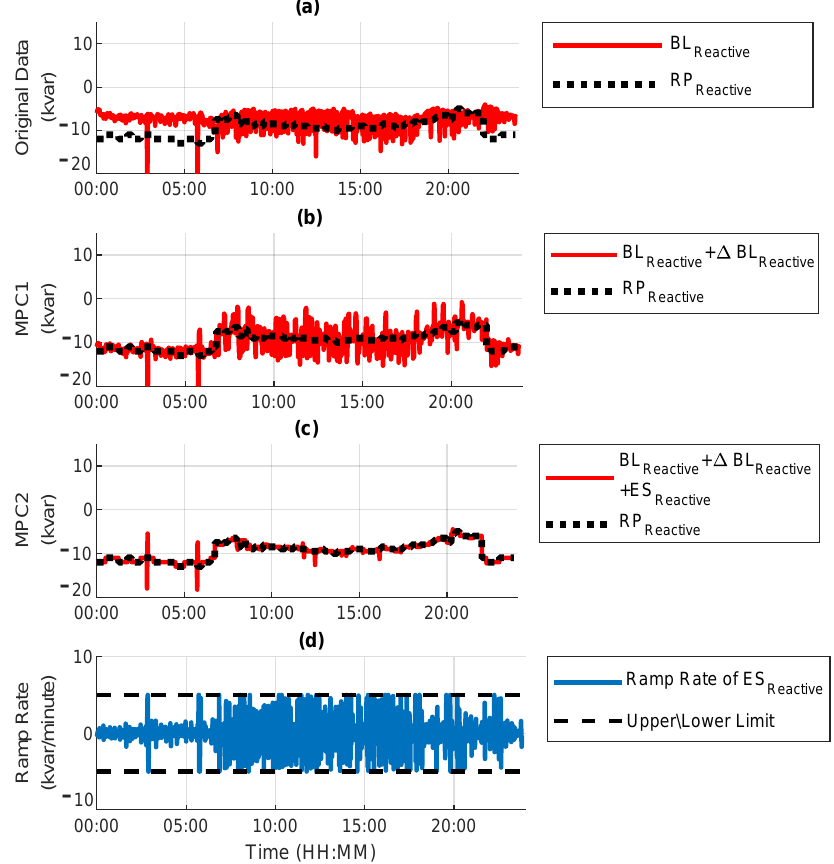
Figure 9. Day 1 reactive power ( a ) original data, ( b ) MPC1 simulation result, ( c ) MPC2 simulation results, and ( d ) ramp rate